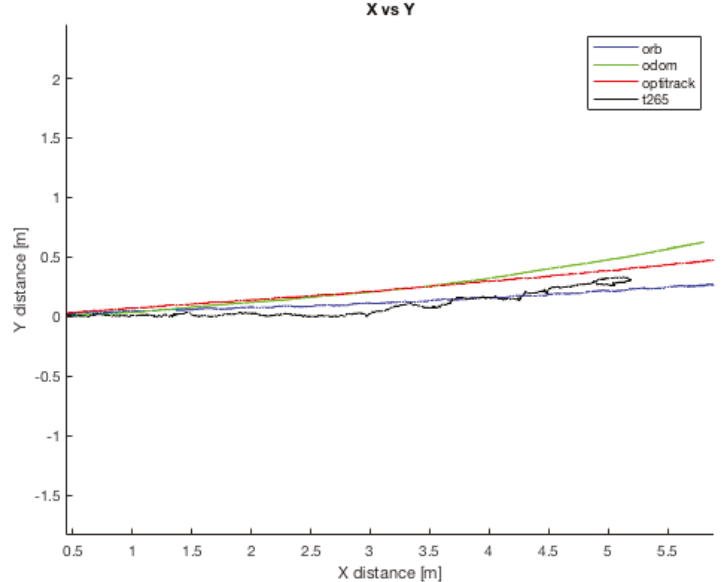
Figure 20. Indoor tests scenario 2. Test 1. Trial 1. Final error XY position.